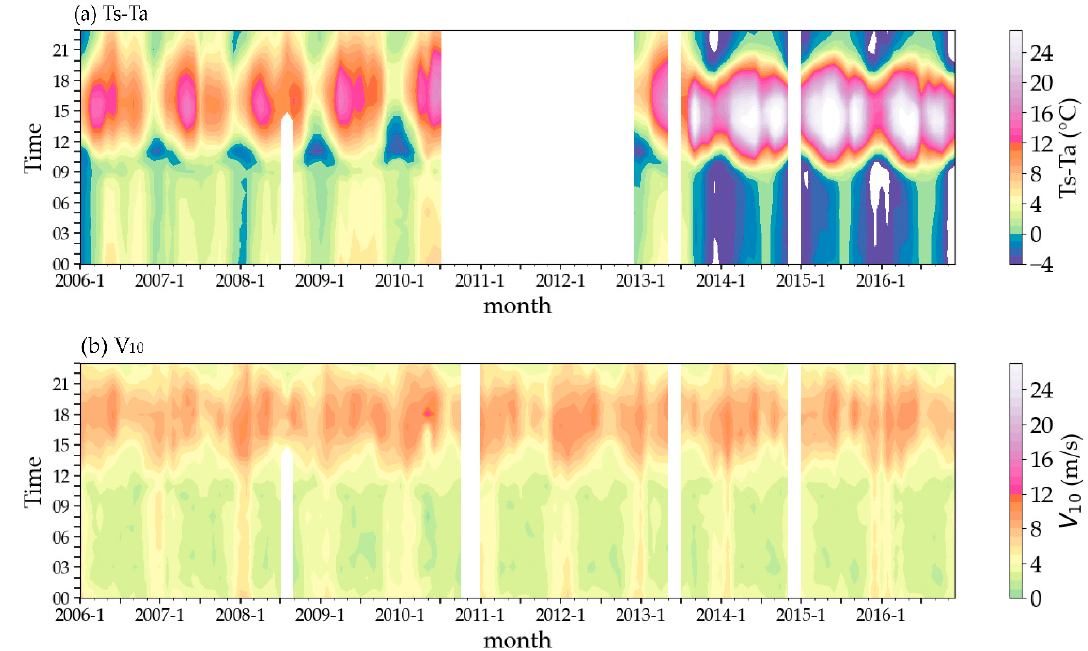
Figure 6. Monthly mean of the diurnal variation in ( a ) land–air temperature difference (Ts-Ta, unit: °C) and ( b ) wind speed at the height of 10 m (V 10 , unit: m/s) at QOMS during the period 2006–2016.